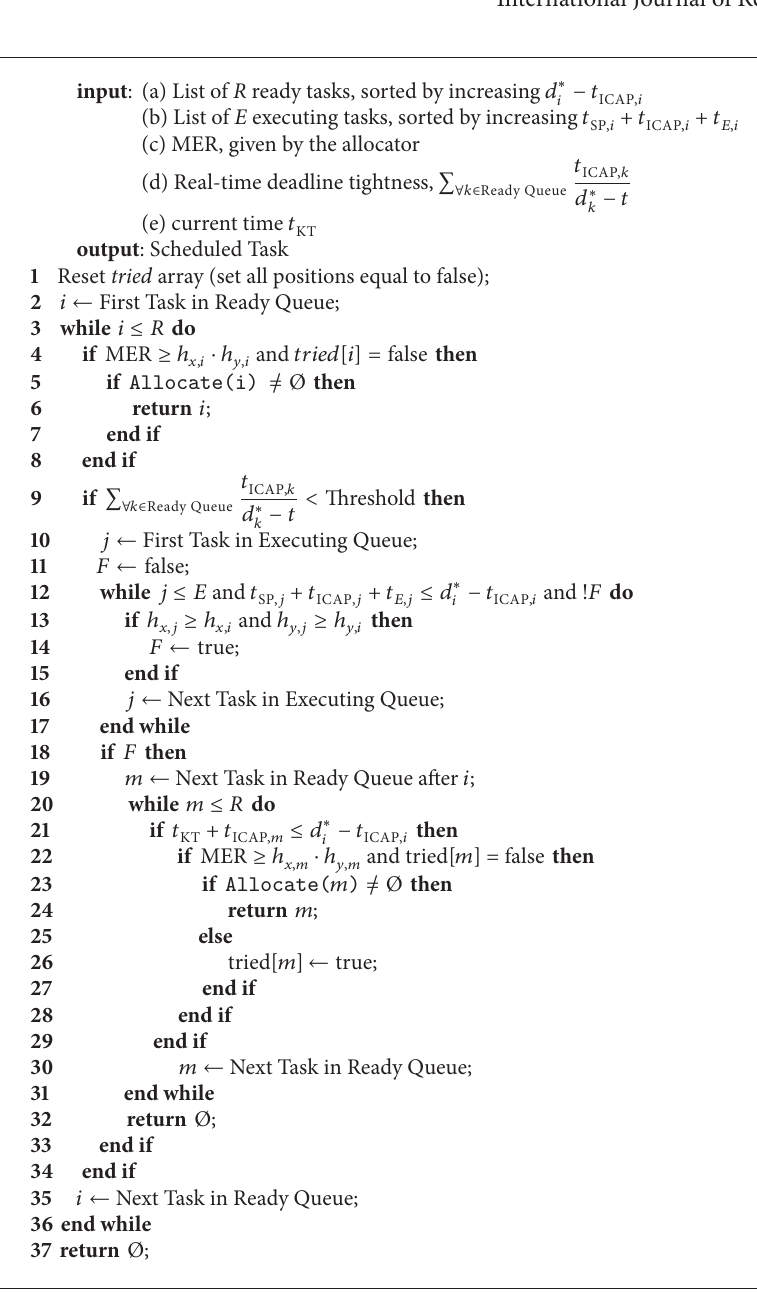
Algorithm 2: Schedule FAEDF()